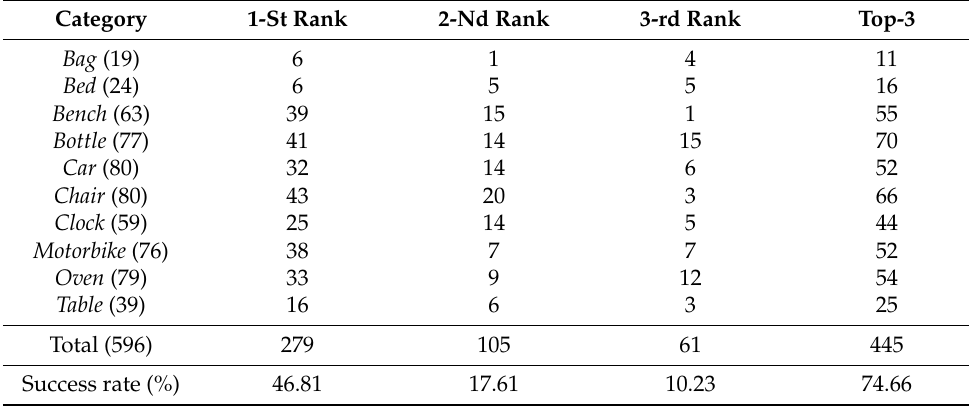
Table 3. CAD model retrieval results using the similarity measurement